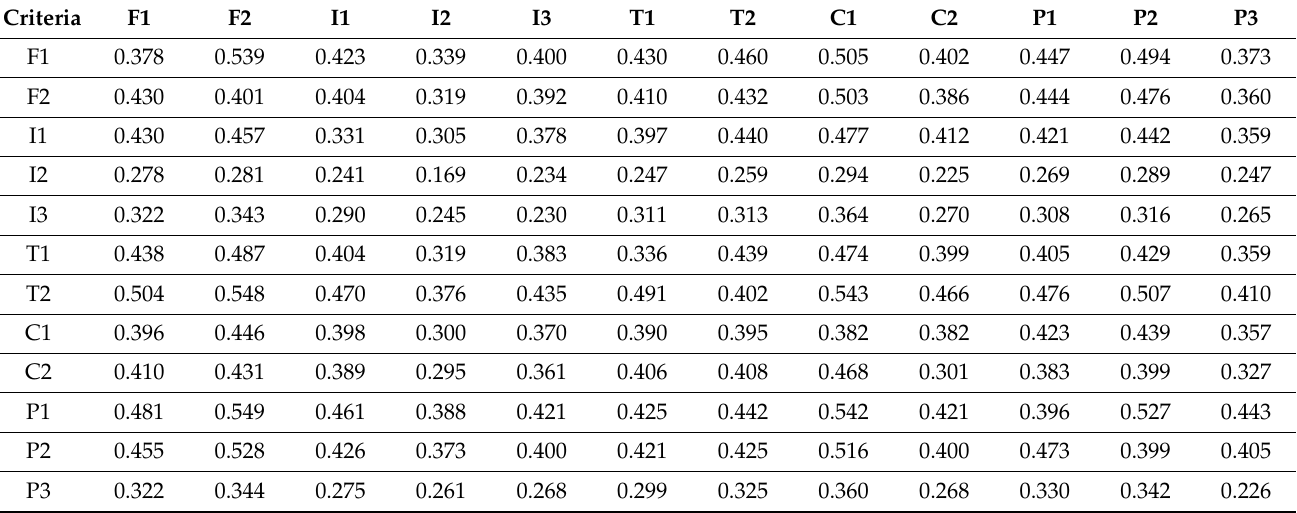
Table A5. Total relation